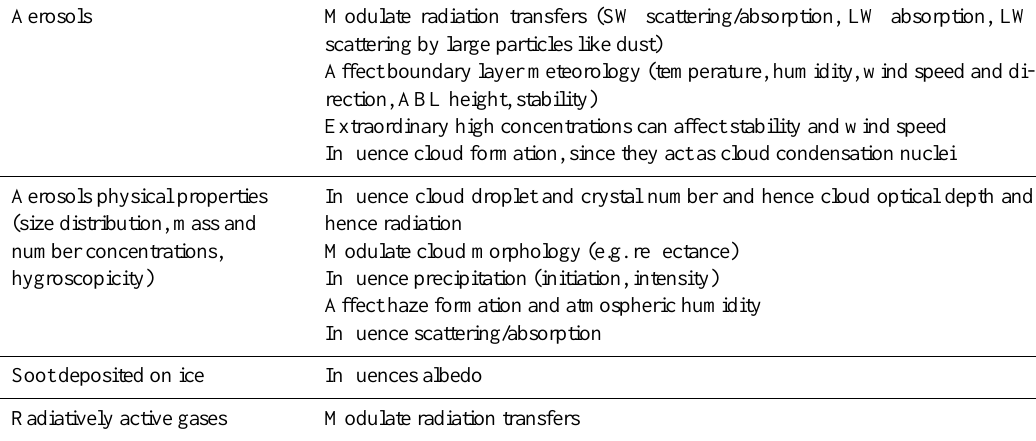
Table 2. Chemical species’ impacts on